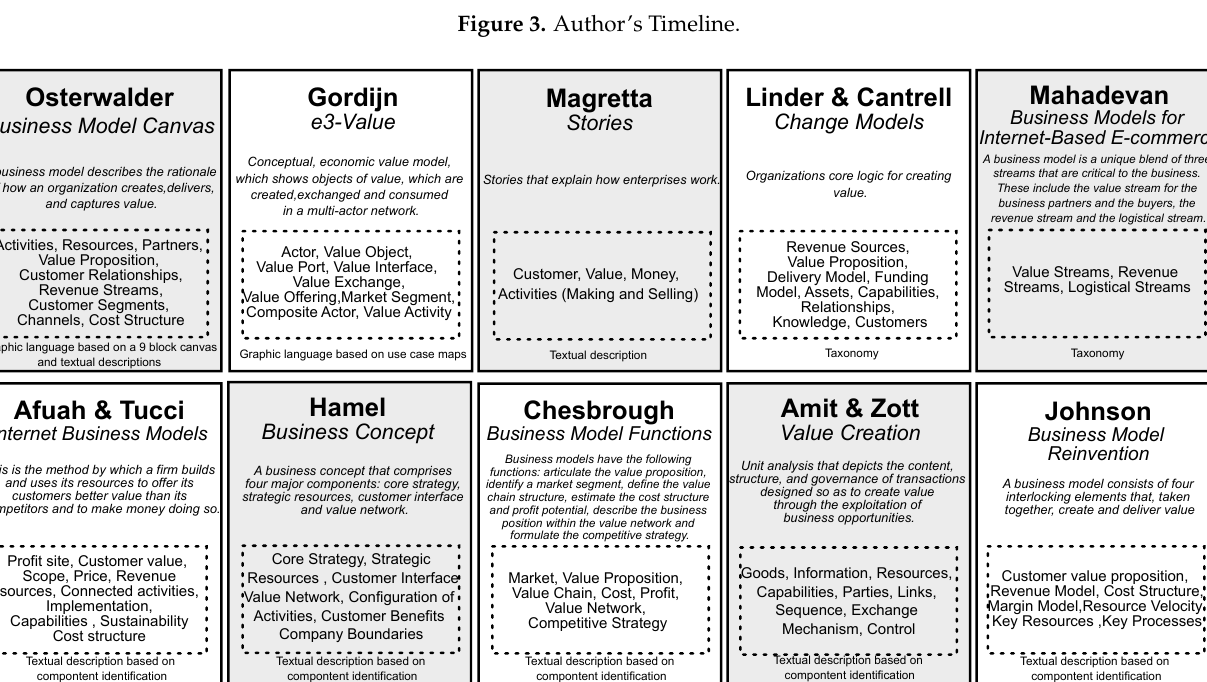
Figure 4. Authors and